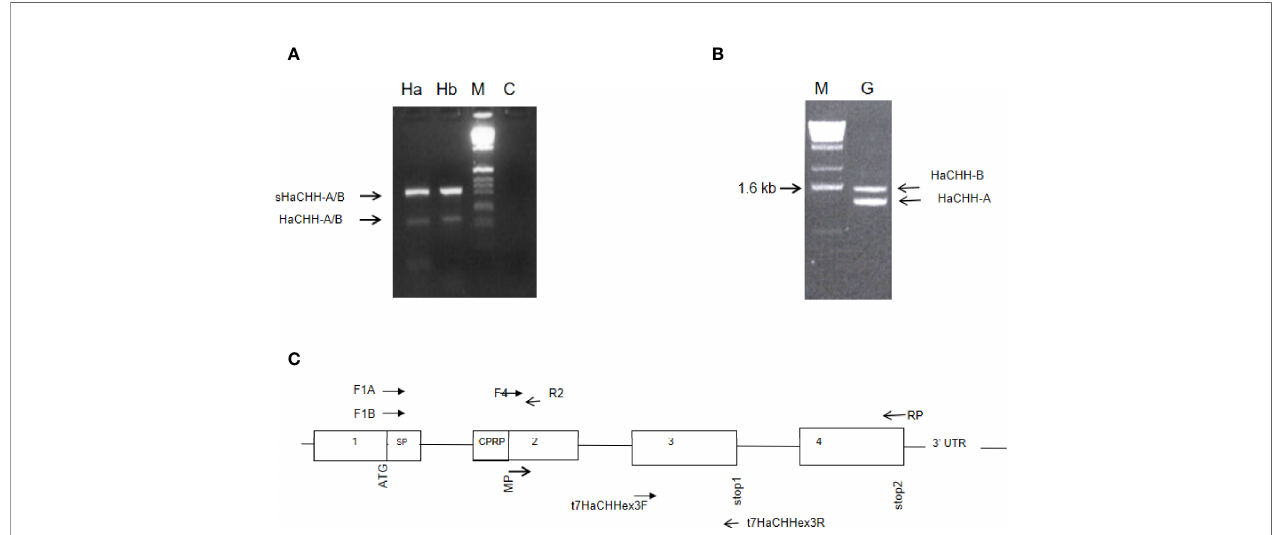
FIGURE 1 | (A) Identi fi cation of transcript variants for the HaCHH-A and HaCHH-B genes. Gene-speci fi c forward primers for HaCHH-A ( F1A ) and HaCHH-B ( F1B ) were paired with common reverse primer ( R2 ) in the RT-PCR ampli fi cation of cDNA from eyestalk ( Es ). Two major fragments were ampli fi ed by each pair of primers. The larger fragment ( upper arrow ) is the sHaCHH-A or the sHaCHH-B transcript variant; the smaller band ( lower arrow ) is for transcripts HaCHH-A and HaCHH-B . (B) Gene from eyestalk cDNA of female lobster. Lane Ha : PCR results using primer pair F1A and RP; lane Hb : results for primer F1B/RP; M : DNA size marker; and C : negative, no template control. (B) Genomic PCR detection of multiple HaCHH-A and HaCHH-B genes. The primer pair F4/RP ( Figure 2 and Table 1 ) was used and two distinctive DNA fragments (i.e., 1.4 and 1.6 kb) were ampli fi ed. (C) Schematic diagram showing the locations of the primers and the proposed gene structure of the HaCHH genes used in this